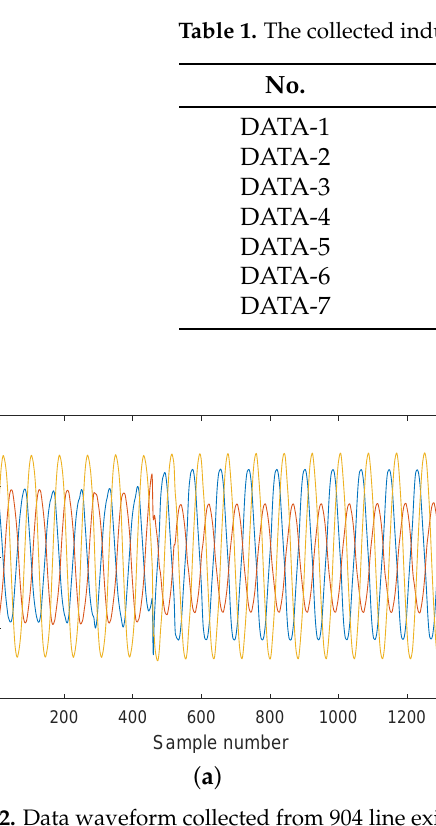
Figure 2. Data waveform collected from 904 line exit. ( a ) Three-phase electric field intensity; ( b ) Three-phase